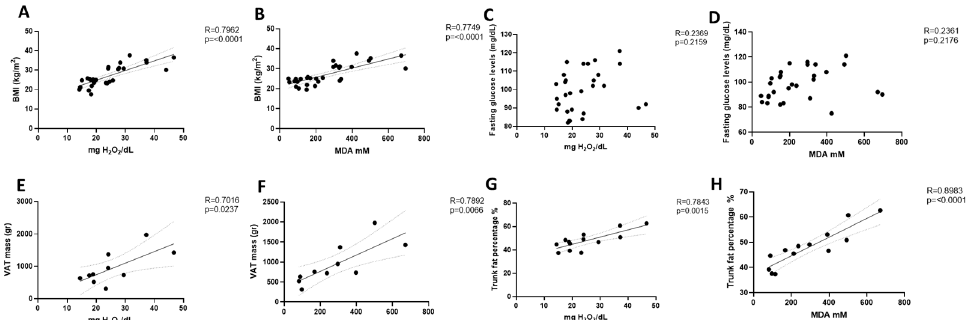
Figure 2. Correlation analysis of oxidative stress markers and body composition parameters. H 2 O 2 and MDA levels were correlated with BMI ( A , B ), fasting glucose levels ( C , D ), VAT mass ( E , F ), and trunk fat percentage ( G , H ) in obese and normal weight postmenopausal women. Analysis was performed using Pearson comparison test. R indicates Pearson correlation